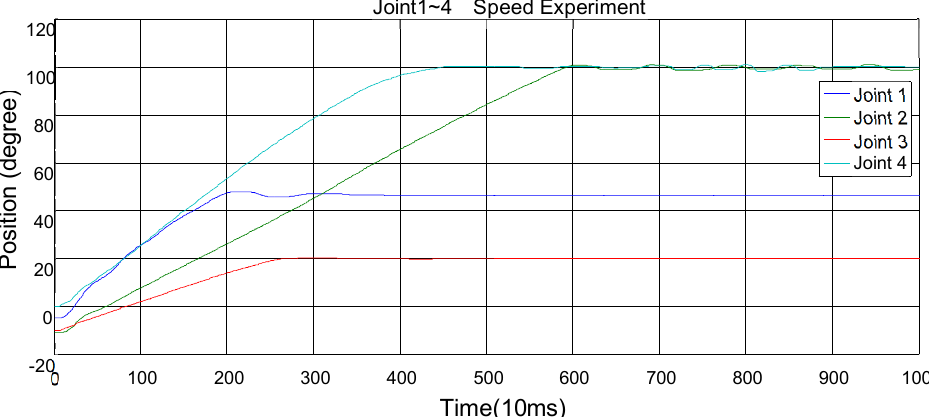
Figure 15. ( a ) Curve of the relationship between desired trajectory and PID controller tracking results. ( b ) Curve of the relationship between the desired trajectory and the tracking result of LMS-PID controller. ( c ) Curve of the relationship between expected trajectory and ILC tracing results.